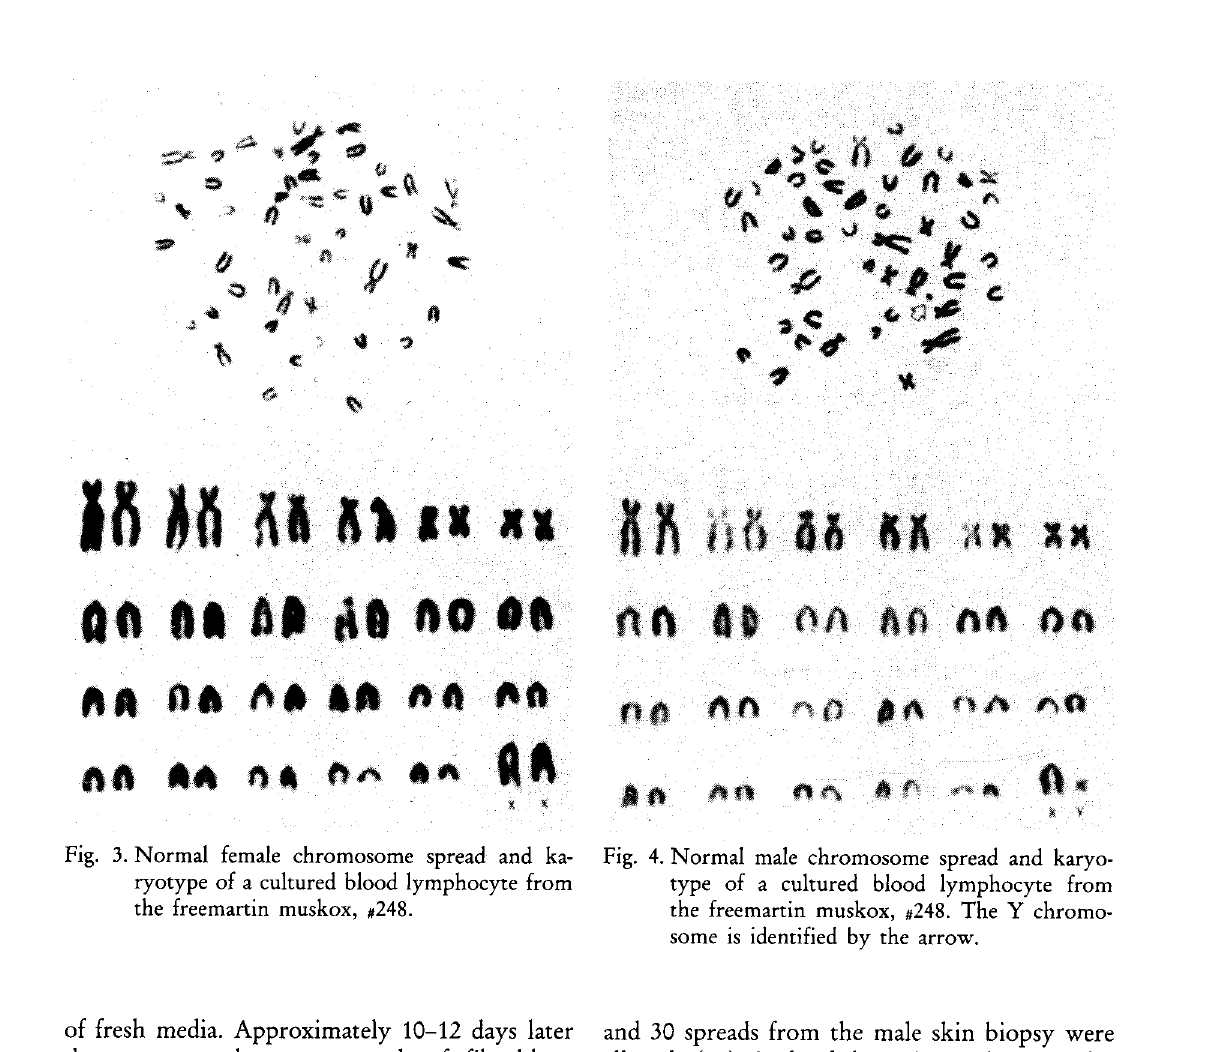
Fig. 3. Normal female chromosome spread and ka- Fig. 4. Normal male chromosome spread and karyo- ryotype of a cultured blood lymphocyte from the freemartin muskox, #248.